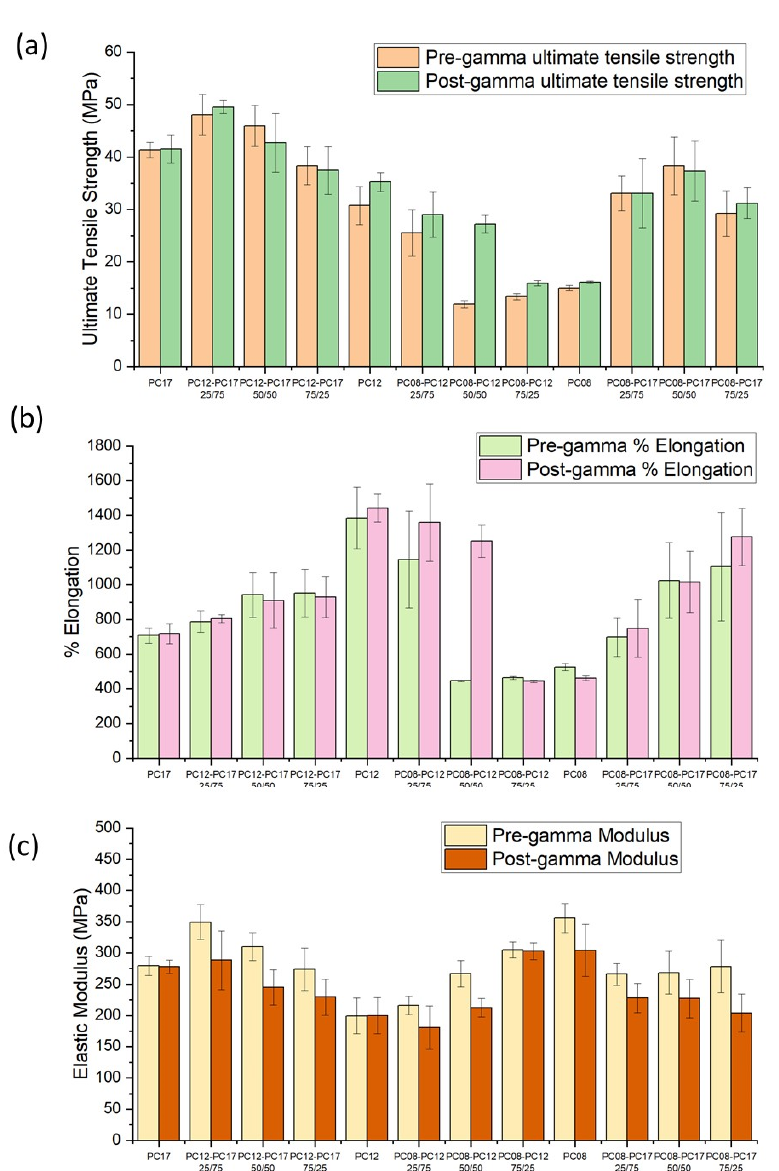
Figure 7. ( a ) The ultimate tensile strength, ( b ) percentage elongation at the break, and ( c ) elastic modulus of extruded Table 2. 5 mm OD, 60 mm length, and 100 µ m wall thickness. The UTS, %elongation, and elastic modulus reflect the mean values ± standard deviation of at least 5 samples.